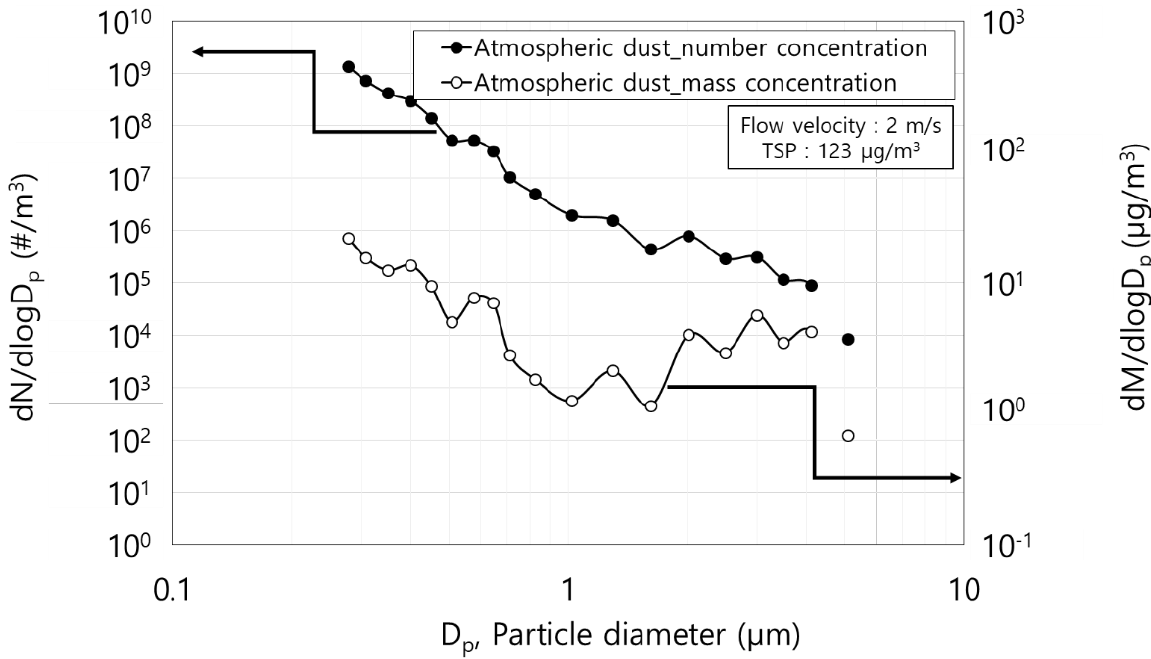
Figure 3. Particle size distribution of the atmospheric dust.